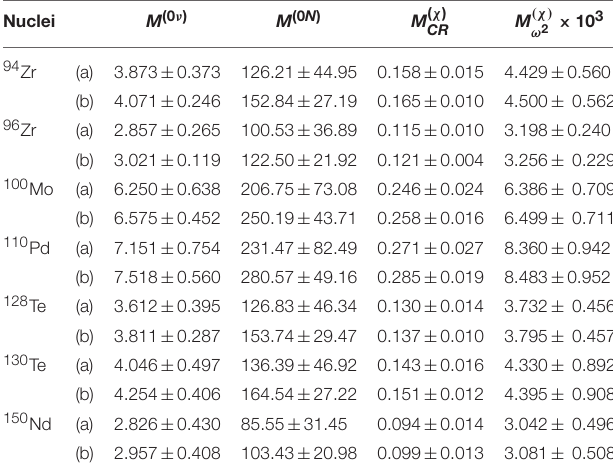
for 94,96 Zr, ω 2